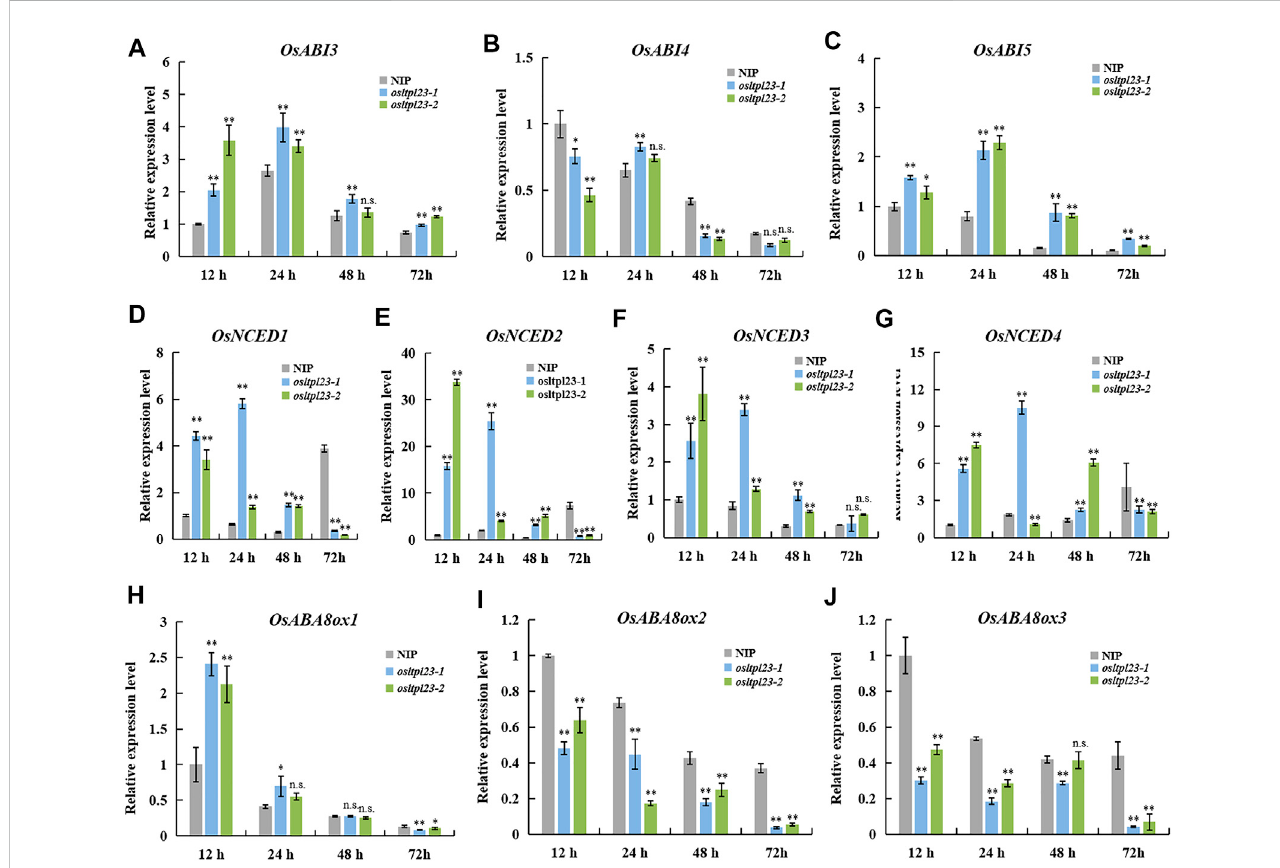
FIGURE 6 OsLTPL23 alters the transcriptionalexpressionof thegenes in ABA-responsive,-biosynthesis and -metabolismpathwayduring seed germination. (A – C) The OsABI3 (A) , OsABI4 (B) and OsABI5 (C) expression in germinated seeds among NIP, osltpl23-1 and osltpl23-2 plants. (D – J) The relative gene expression levels of ABA biosynthesis genes OsNCED1 (D) , OsNCED2 (E) , OsNCED3 (F) and OsNCED4 (G) , and ABA metabolism genes OsABA8ox1 (H) , OsABA8ox2 (I) , and OsABA8ox3 (J) in germinated seeds among NIP, osltpl23-1 and osltpl23-2 plants. The gene expression levels of NIP at 12 hpi was used as control. Values are the mean ±standard deviations of three biological replicates. Signi fi cance were generated by Student ’ s t-test with * p < .05 and ** p < .01.